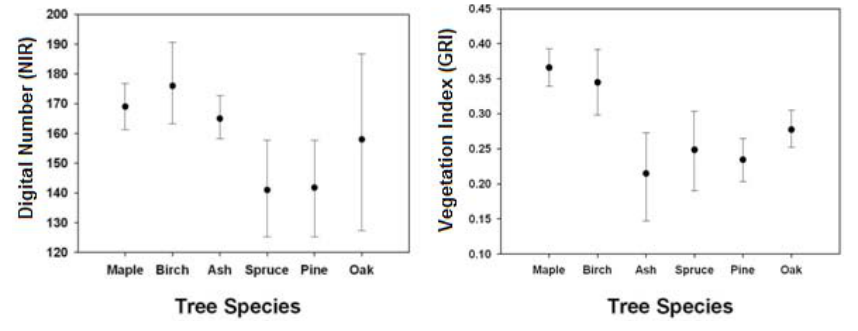
Figure 7. The NIR ( Left ) and GRI ( Right ) mean and maximum/minimum boundaries for six tree